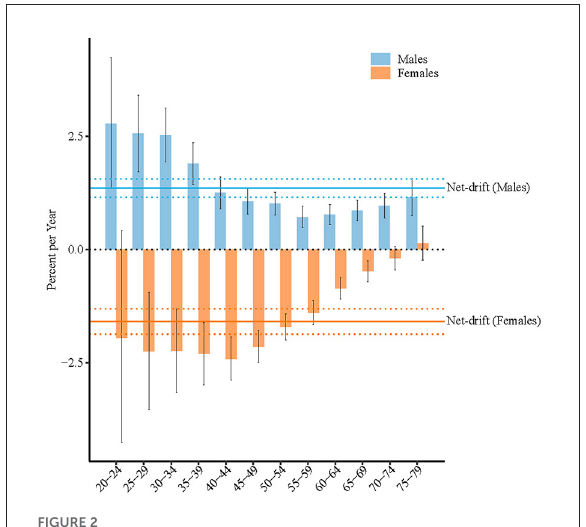
FIGURE2 Net drift and local drift values for high-BMI-attributable stroke mortality in China. Age group-specific annual percent change (local drift) with the overall annual percent change (net drift) in high BMI-attributable stroke mortality rate. Net drift values are depicted as solid lines, with dashed lines representing their 95% CIs. Error bars represent the 95% CIs for the local drift values.